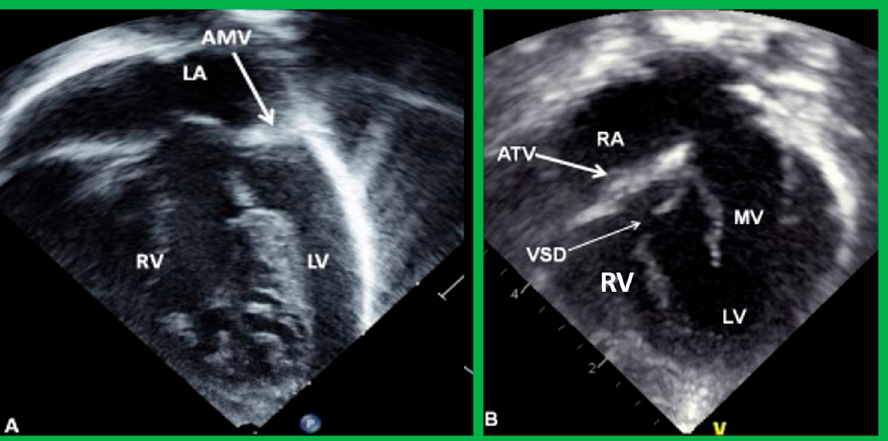
Figure 45. ( A ) Echo frames in apical four-chamber view of a patient with mitral atresia demonstrating atretic mitral valve (AMV), pointed out by an arrow in ( A ). A large right ventricle (RV), a small left atrium (LA), and a small left ventricle (LV) are also visualized. ( B ) Echo frames in apical four-chamber view of a patient with tricuspid atresia, demonstrating atretic tricuspid valve (ATV) shown by the thick arrow in ( B ). Dilated LV, a small RV, and moderate-sized ventricular septal defect (VSD; thin arrow in ( B )) are also seen. Mitral valve (MV) and right atrium (RA) are labeled.